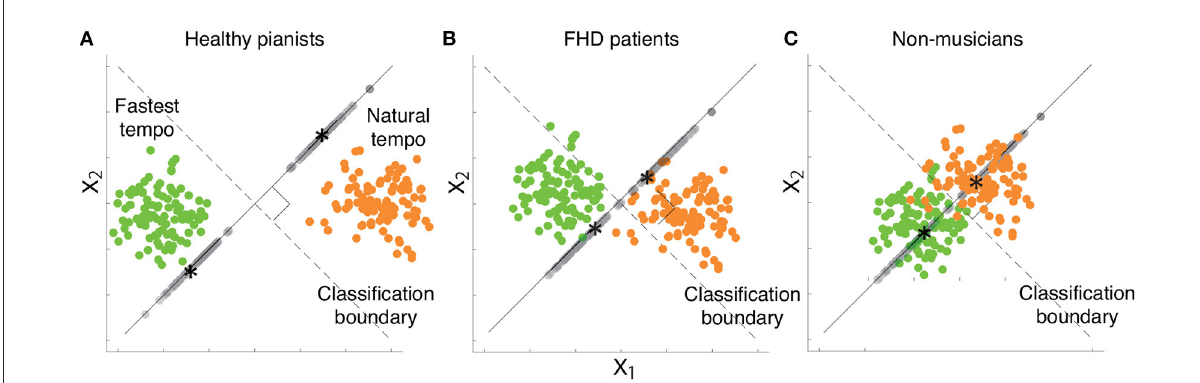
FIGURE7 Schema of our results based on two-dimensional simulated data while considering a desired classification boundary (the black dotted line). Green and orange dots indicate simulated data from a single trial associated with the fastest and natural tempi, respectively. Gray dots denote each data point projected onto a line orthogonal to the classification boundary. Black asterisks indicate the mean of the projected data associated with the fastest or natural tempo. (A) Simulated data that indicate kinematic features in healthy pianists. (B) Simulated data that indicate kinematic features in patients with FHD. (C) Simulated data that indicate kinematic features in